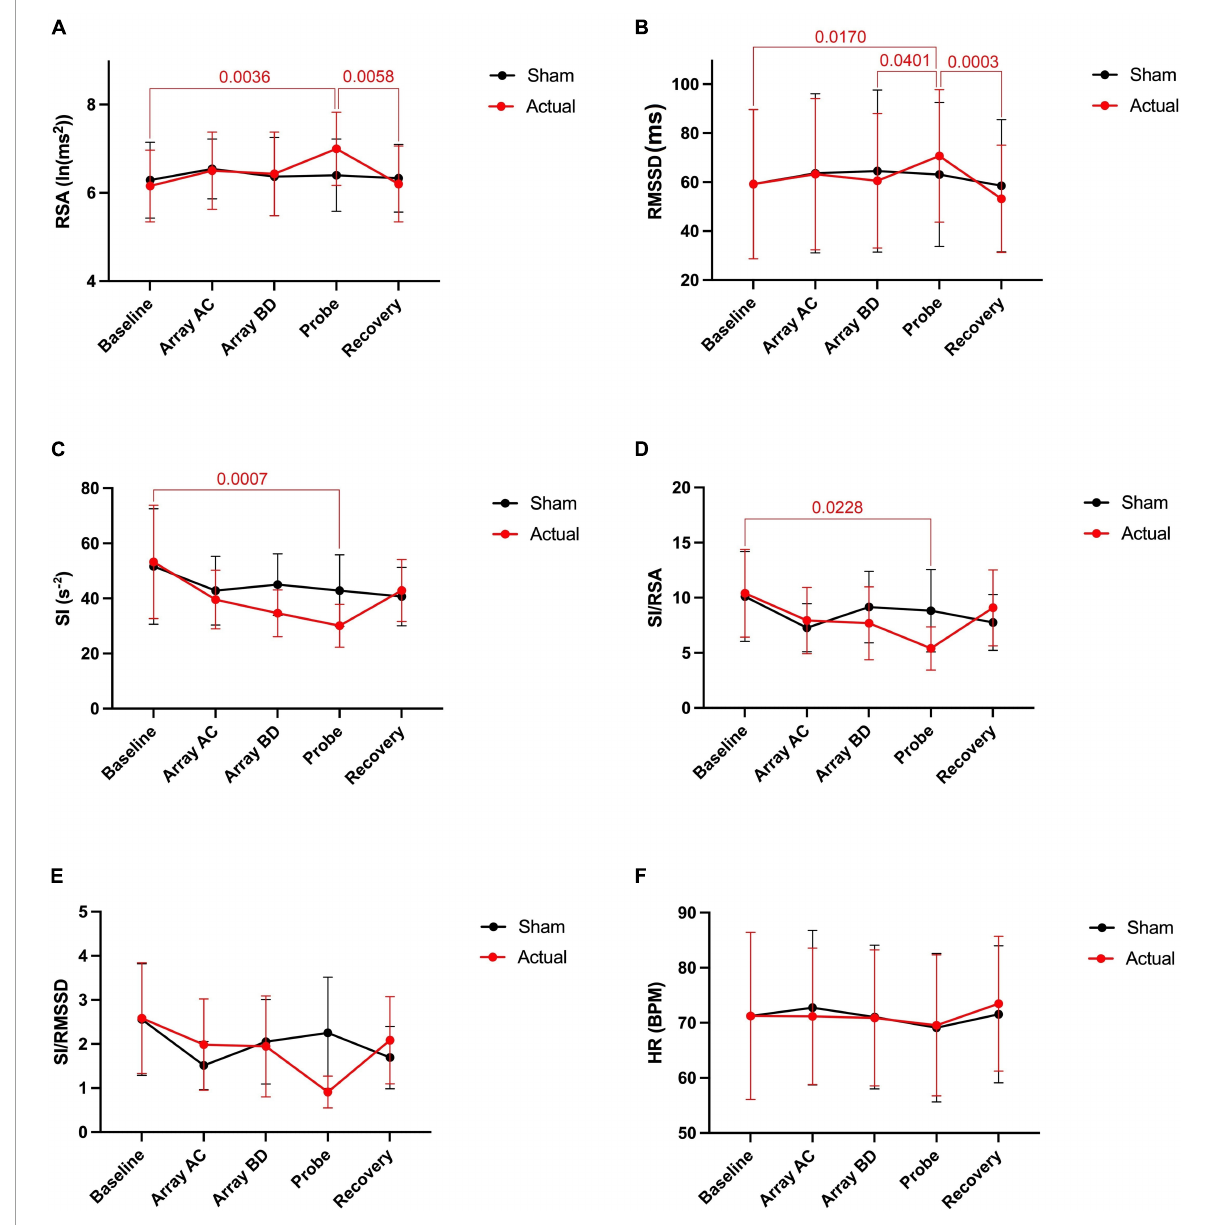
FIGURE5 Autonomic nervous system modulation as deduced from HRV changes during one session of low-level laser therapy, stimulating the lumbar and sacral spine. (A) RSA, (B) RMSSD, (C) SI, (D) SI/RSA, (E) SI/RMSSD, (F) HR. Average values ± SEM from 6 healthy subjects during sham (placement of arrays and probe but no stimulation) and during actual activation of the arrays and